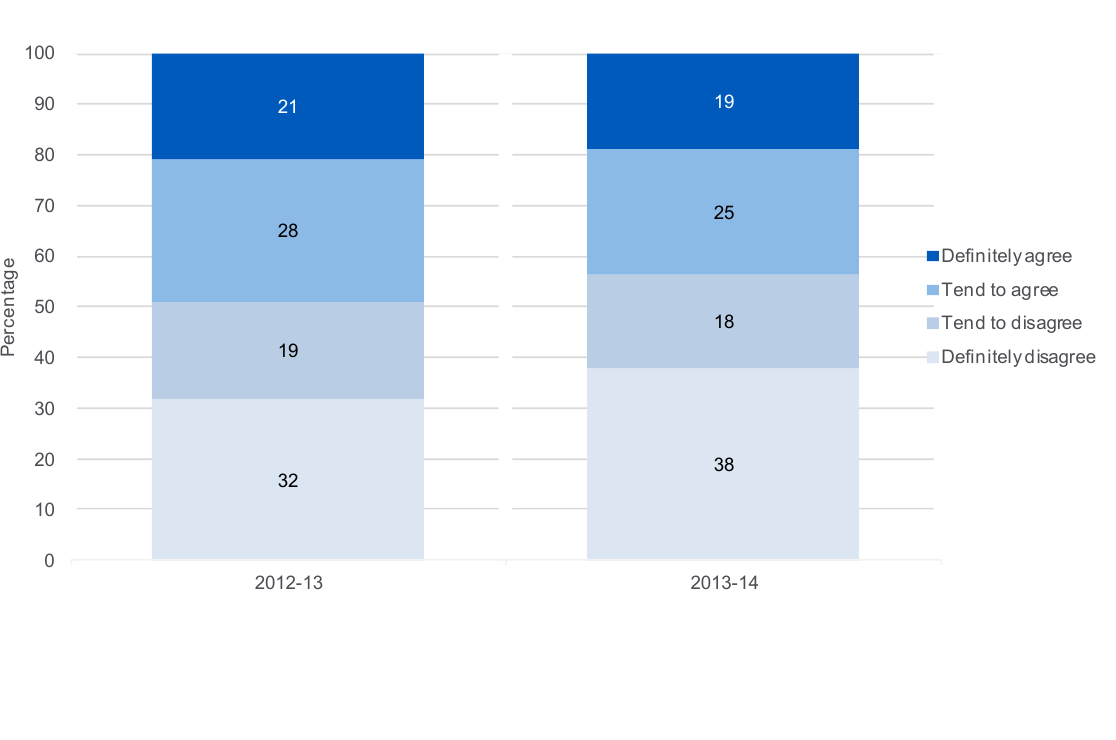
-Table 20: Whether people borrow things and exchange favours with their neighbours, 2012- 13 to 2013-14